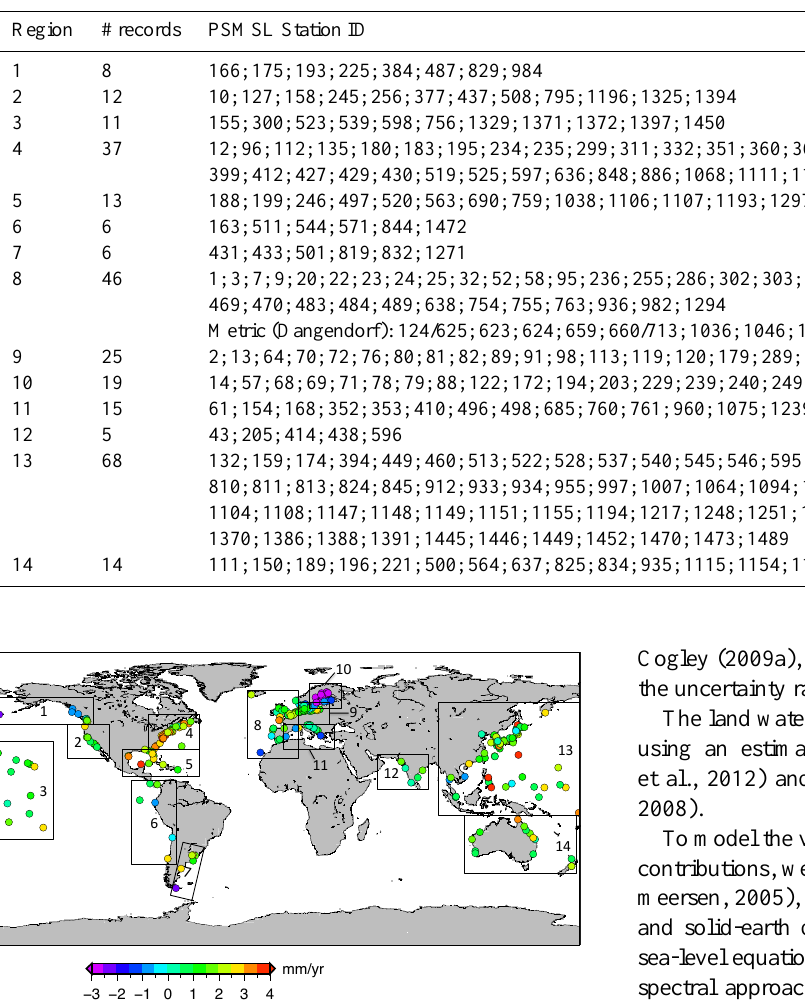
Figure 1. Tide gauge trends (mmyr − 1 ) for the period 1961–2003; 285 checked records with each at least 20years of data are sorted into 14 regions. Data are from the PSMSL data base (Holgate et al., 2013). Region 12 contains the least records (5), region 13 the most